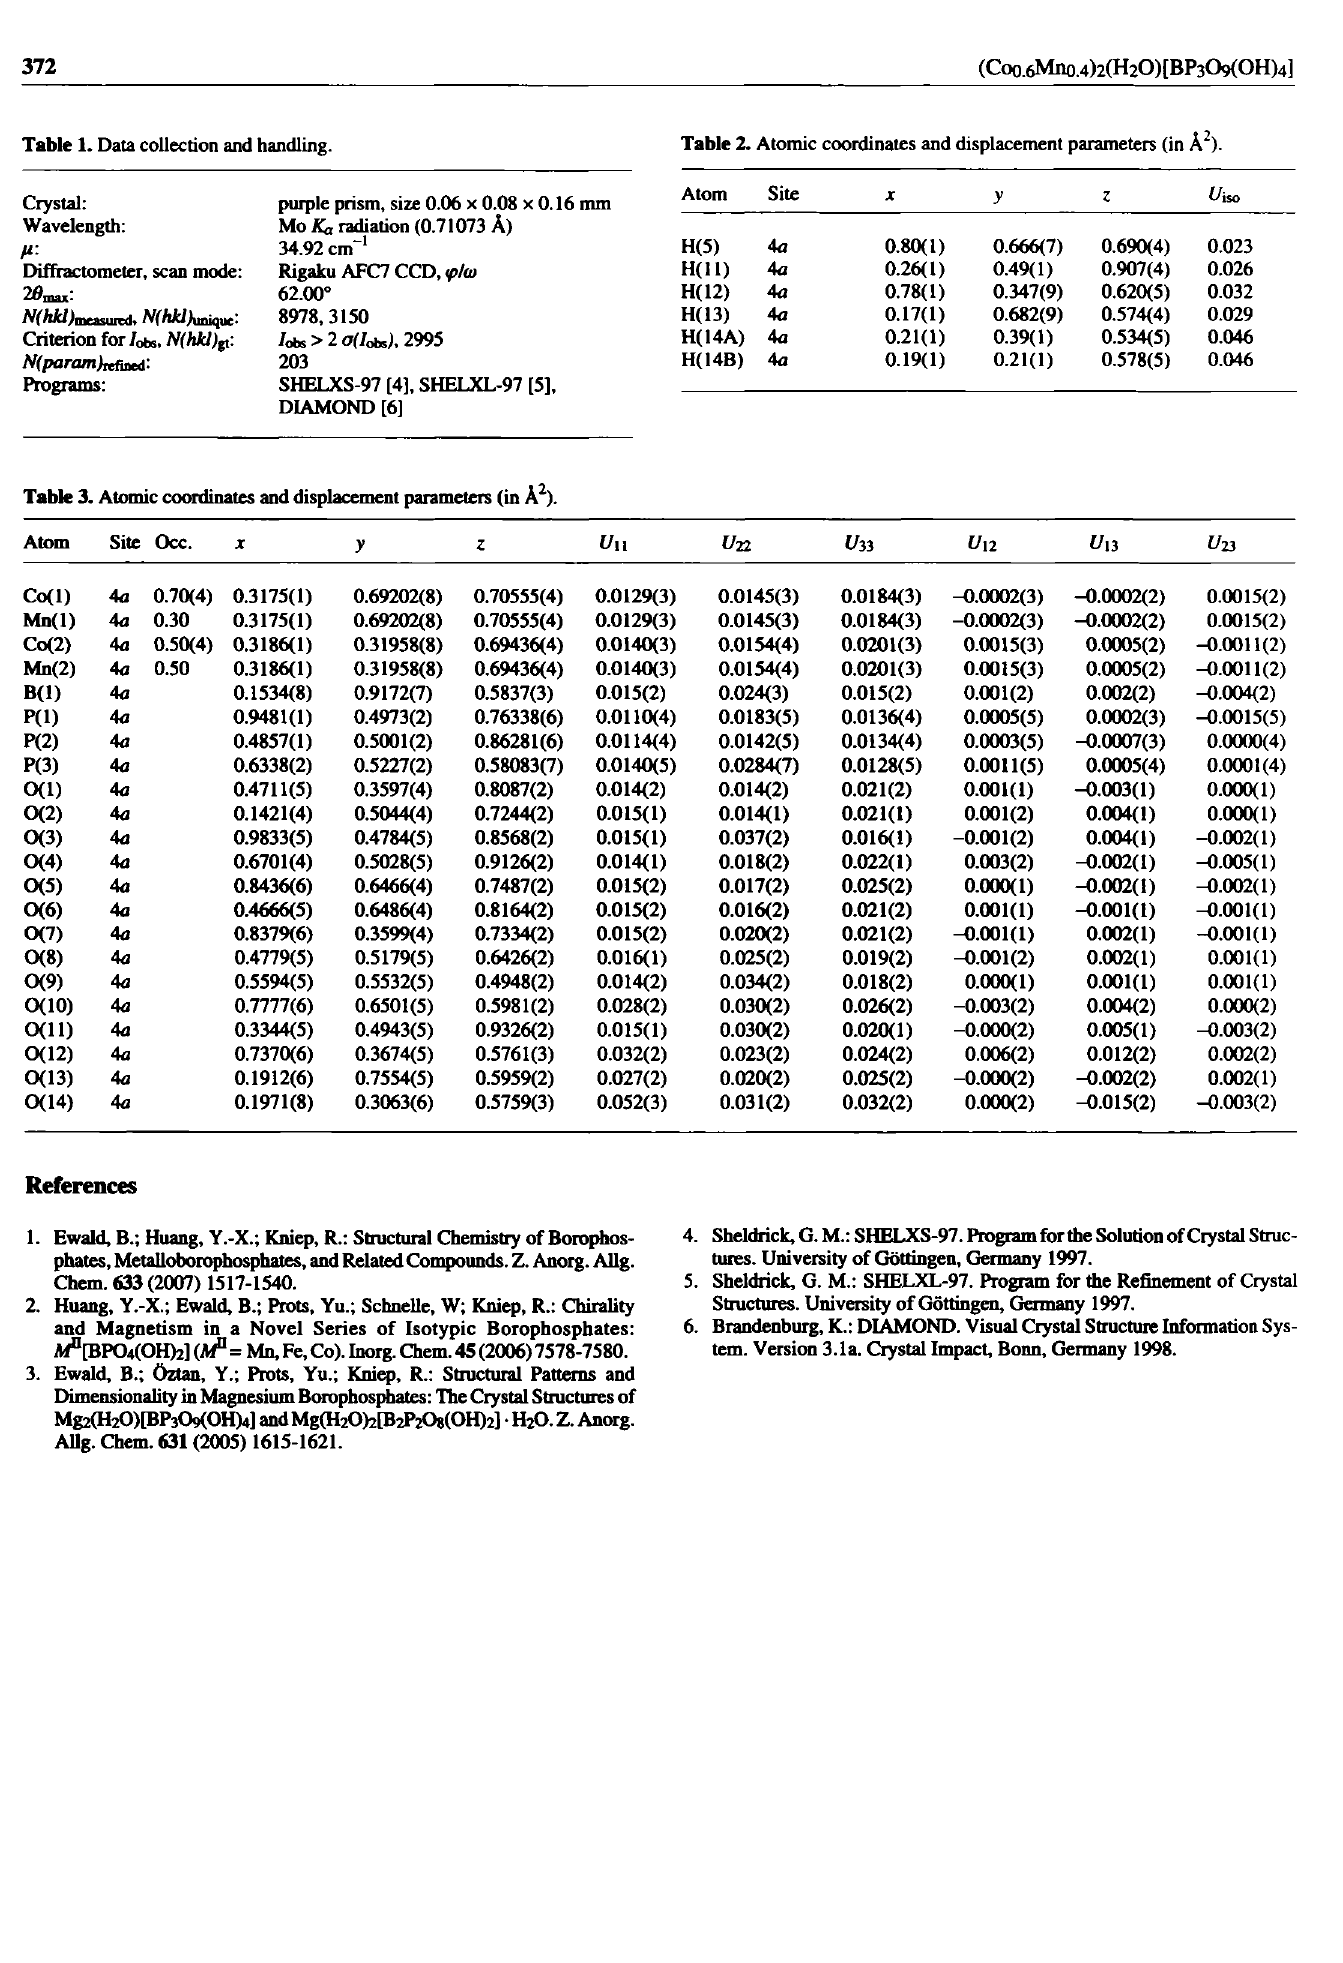
Table 1. Data collection and handling. Table 2. Atomic coordinates and displacement parameters (in À 2 ).